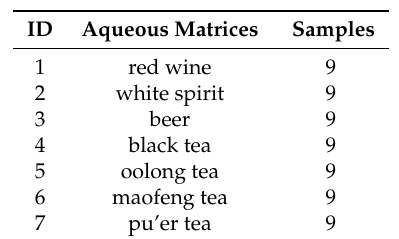
Table 2. Data set of 7 aqueous matrices used to validate the developed artificial taste recognition